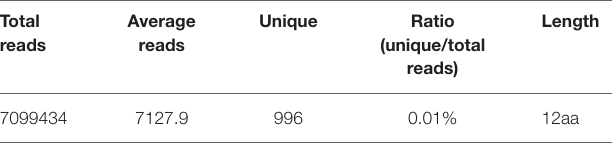
TABLE 3 | The reads of high-throughput sequencing after Ph.D.-12 TM Phage Display Peptide screening.